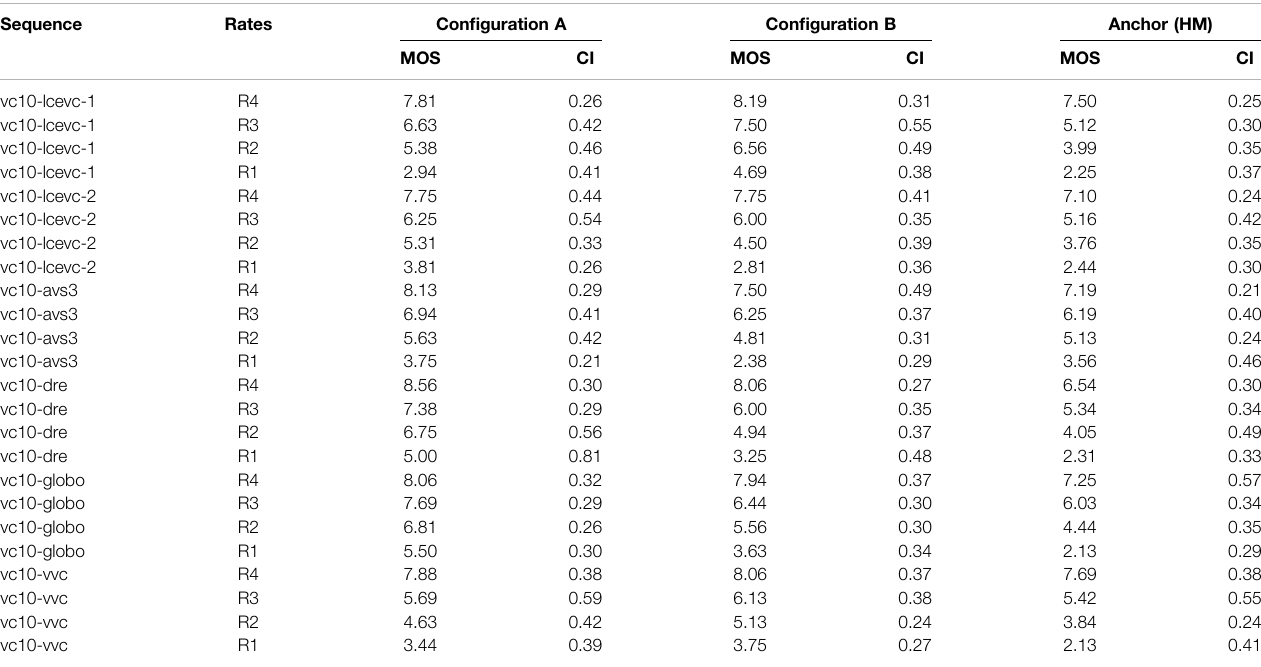
TABLE 3 | MOS scores and CI for PQ